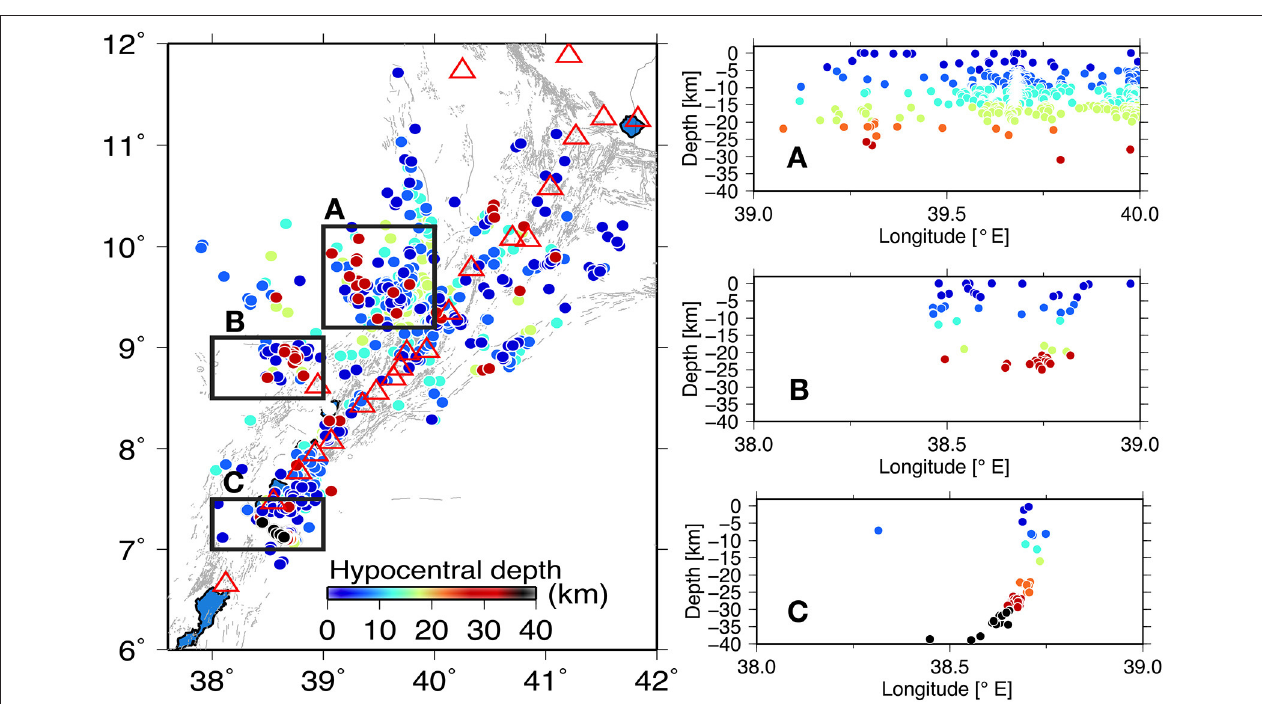
FIGURE 2 | Depth distribution of seismicity in the NW plateau (A) , Yerrer Tullu-Wellel volcanic lineament (YTVL) (B) and central MER (C) . The open black boxes show the location of cross-sections in (A–C) . Seismicity extends to ∼ 32 km (A) , whereas in the central MER earthquake occurs to a depth of ∼ 38 km. In cross section (C) , we show only earthquakes from Lapins et al. (2020). These earthquakes have maximum lateral uncertainty < 10 km (Lloyd et al.,